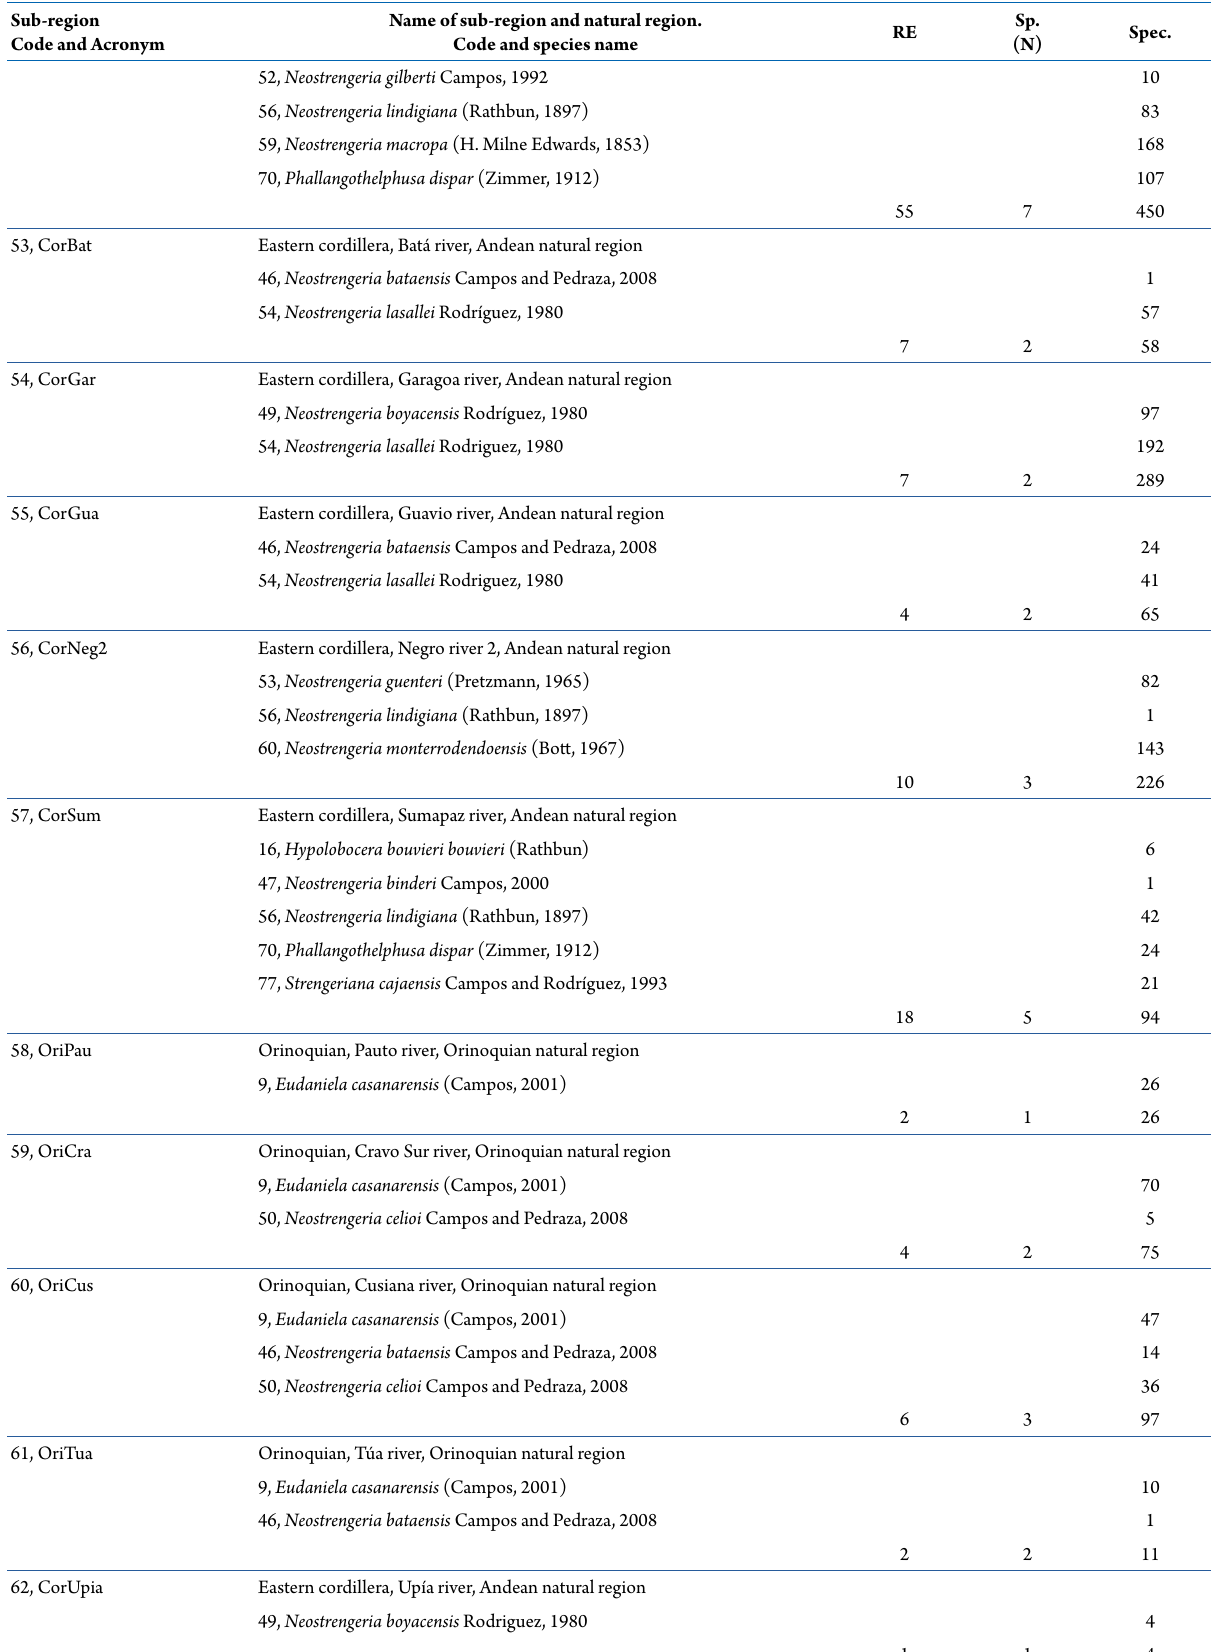
Table 2. Sub-region Code and Acronym